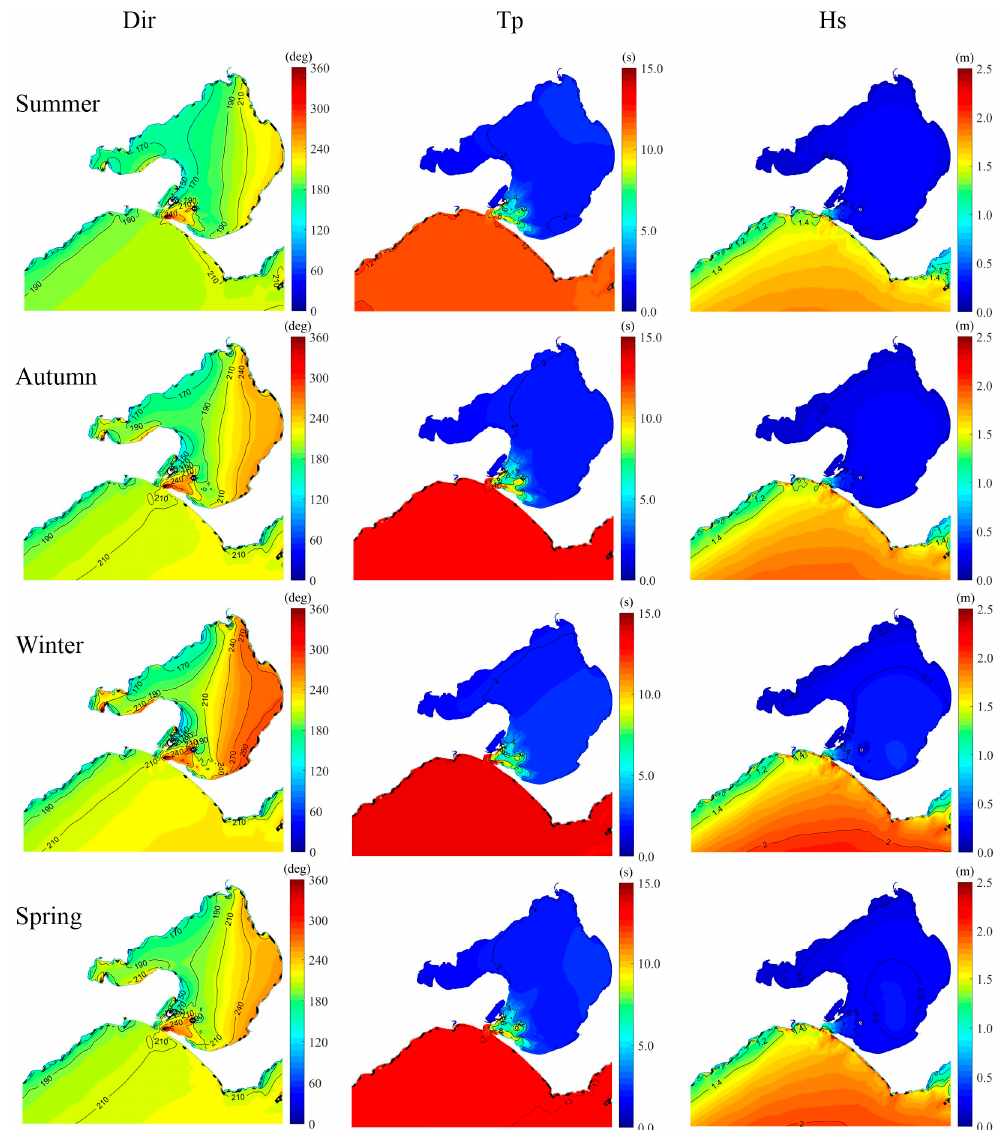
Figure 10. Spatial distribution of mean wave direction (Dir), wave peak period (Tp) and SWH (Hs) for the four seasons. For the ease of interpretation, the same color-scale is kept for both mean value in this figure and the higher percentiles and extremes in Figure 11.